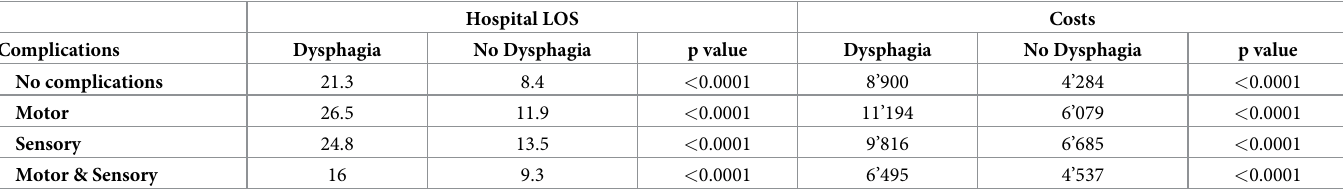
Table 5. Hospital LOS and Costs of Hospital stays for stroke with vs. without dysphagia by subgroups in